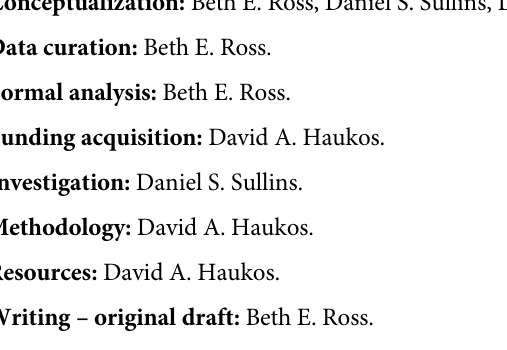
S1 Fig. Mean and 95% CIs for output of simulated lesser prairie-chickens from Scenario 7N & 8N (left) and 7N & 10N (right). S2 Fig. Estimated detection probabilities of simulated lesser prairie-chicken populations over a 25-year period. Black points represent true values of detection probability (p = 0.5; Sce- nario 7) while gray represents estimates from N-mixture model results with mean (points) and 95% quantiles (whiskers) from each